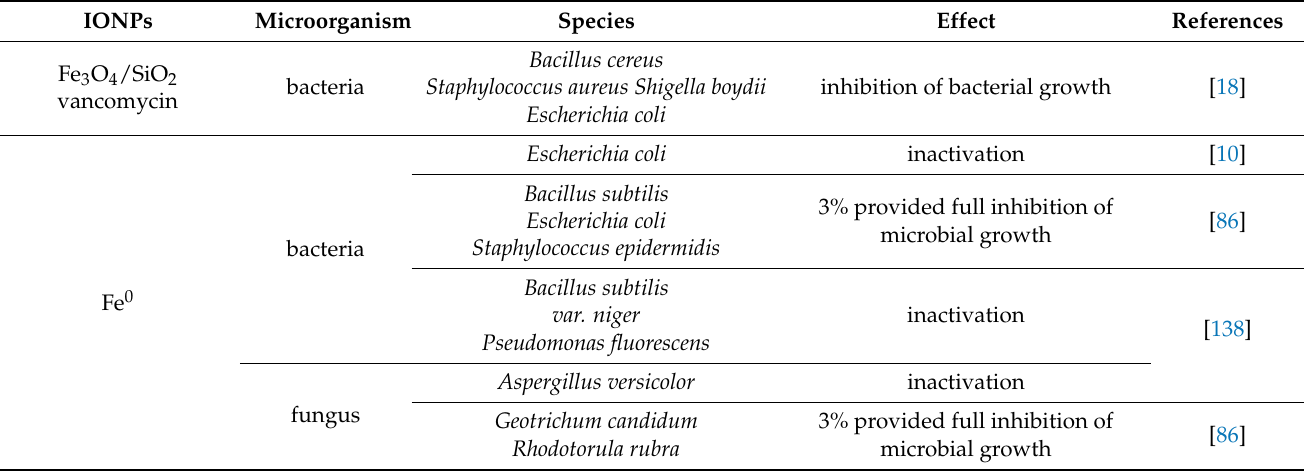
Table 6. The ways in which IONPs interact with